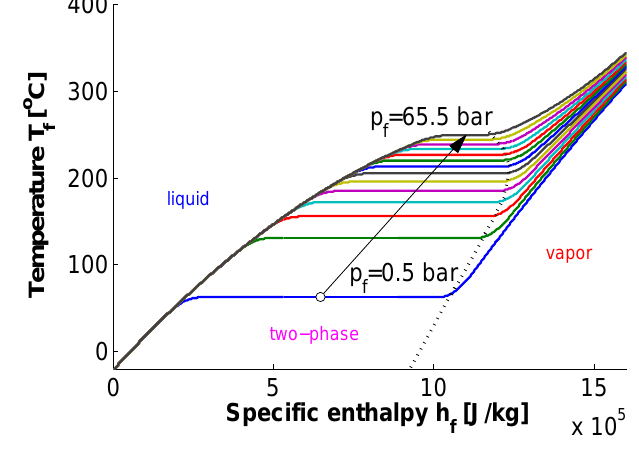
Figure 2. Ethanol temperature as a function of specific enthalpy and